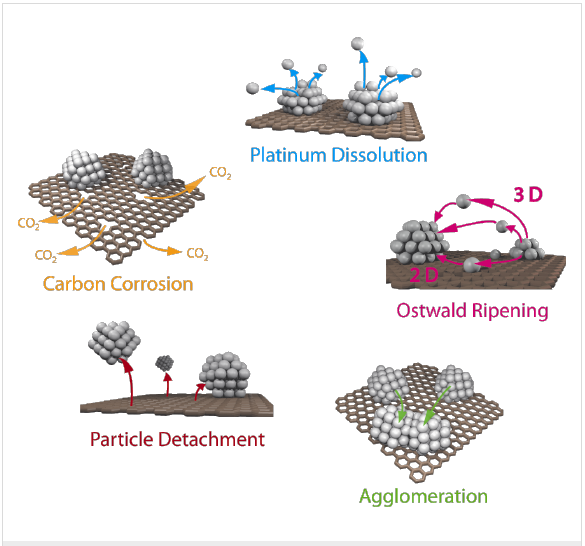
Figure 1: Simplified representation of suggested degradation mecha- nisms for platinum particles on a carbon support in fuel